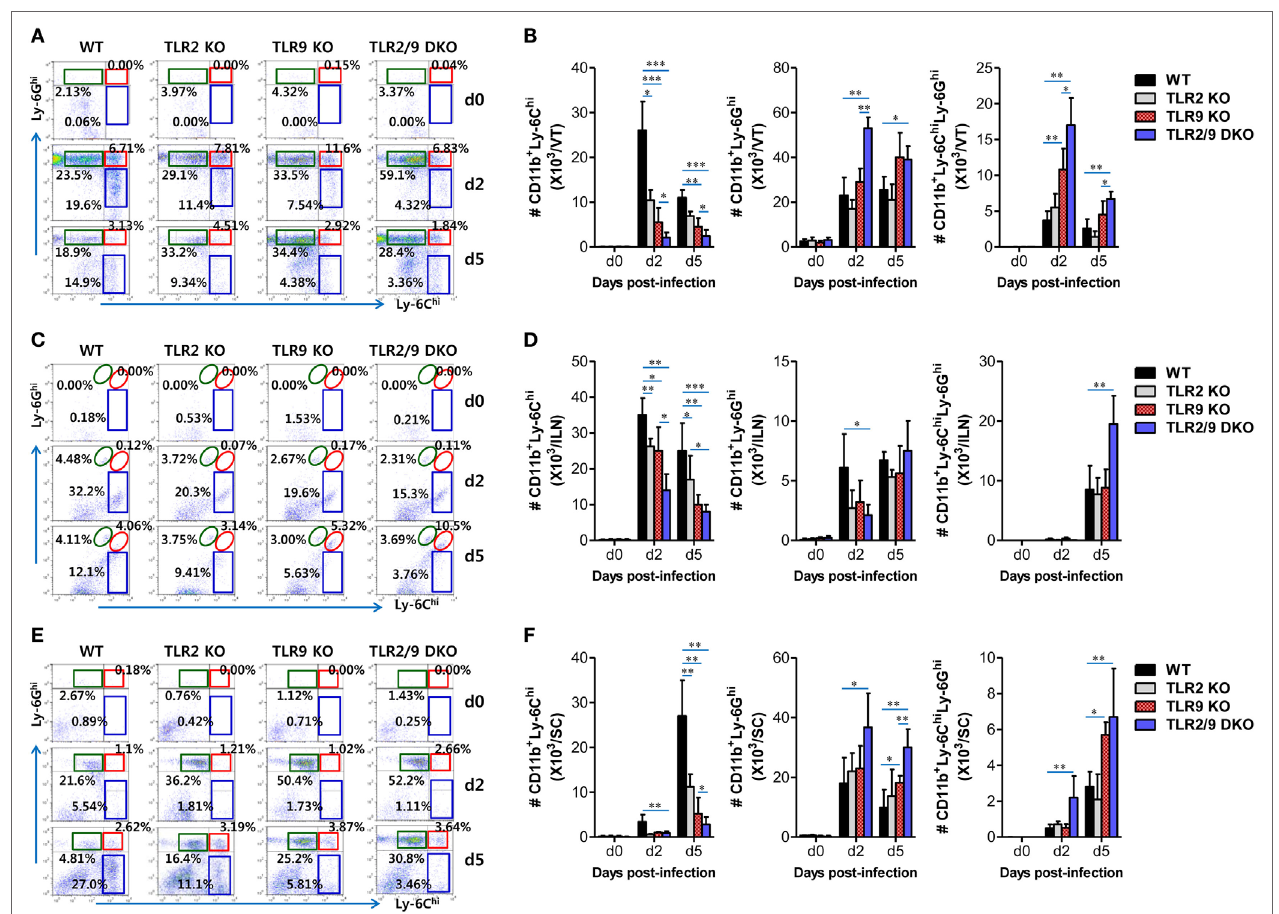
FigUre 2 | Both TLR2 and TLR9 are required for early accumulation of Ly-6C hi monocytes into inflamed and lymphoid tissues following mucosal herpes simplex virus (HSV)-1 infection. Cells were prepared from the vaginal tract [VT, (a,B) ], iliac LNs [ILNs, (c,D) ], and spinal cord [SC, (e,F) ] with collagenase digestion at 0, 2, and 5 days after mucosal HSV-1 infection (1 × 10 7 pfu/mouse) and employed to determine the subcellular proportion of Ly-6C hi monocytes and Ly-6G hi and Ly-6C hi Ly-6G hi neutrophils using flow cytometric analysis. The values in the dot-plots represent the average percentages of each population derived from four independent samples after gating on CD11b + cells. (a,c,e) The frequency of each cell population. (B,D,F) The accumulated absolute number of each cell population. Data in the bar graphs denote the average ± SEM of the levels derived from at least three independent experiments ( n = 3–4). Two-way ANOVA followed by Bonferroni post hoc testing was conducted in (B,D,F) . * p < 0.05; ** p < 0.01; *** p < 0.001 comparing levels between the indicated